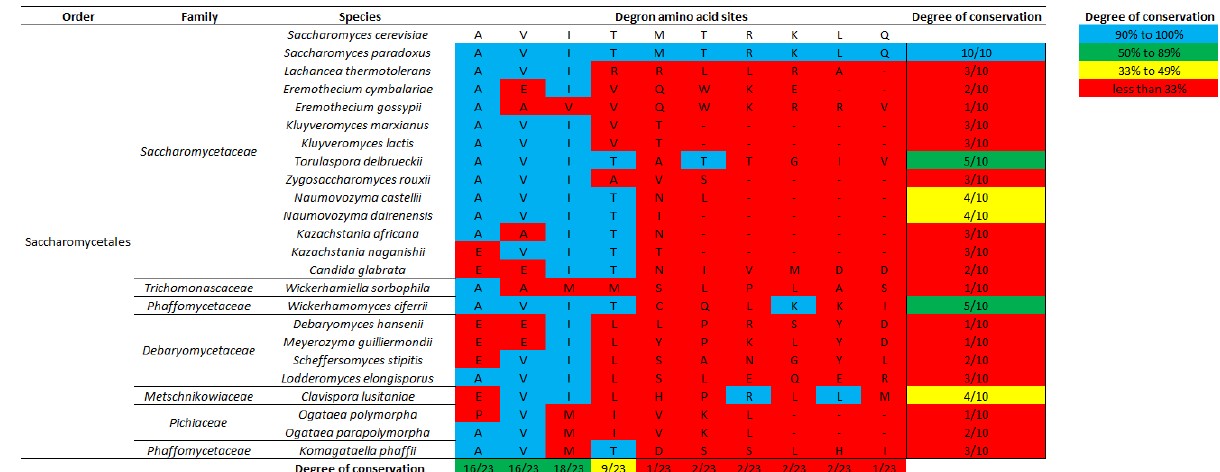
Figure 3. Local amino acid alignments at 24 putative yeast degrons show that the degron sequence is conserved between two Saccharomyces species but not by any other yeast (See Materials and Methods for determination of degron-encoded amino acid sequences). Highlighted blue and red are matching and mis-matching amino acid sites, respectively, in yeast degrons against the reference S. cerevisiae degron. Degree of conservation designates the total number of matching amino acid residues, at the whole degron (last column) and at each amino acid site (last row), with scores in blue highlights high similarity (90–100%), in green highlights medium similarity (50–89%), in yellow highlights medium-low similarity (33–49%), and in red highlights low similarity (>33%).